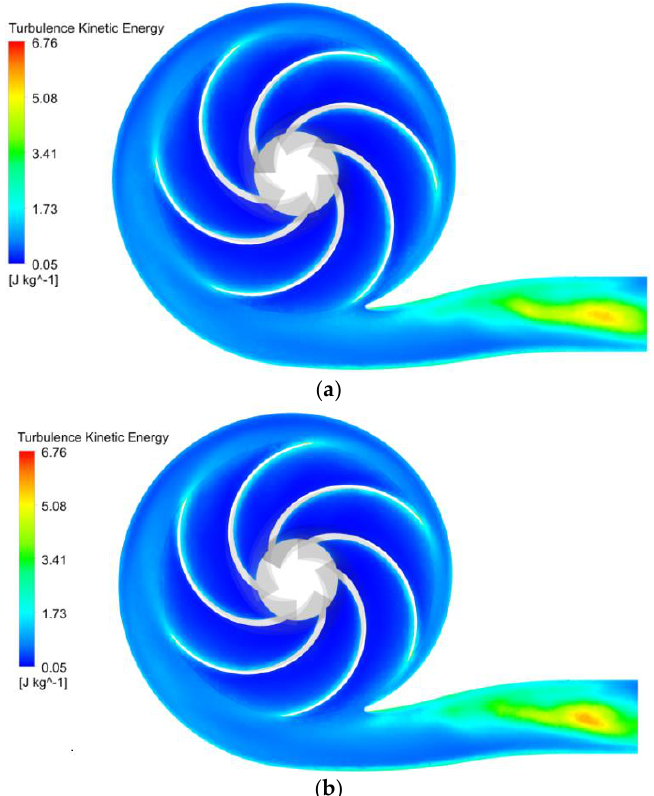
Figure 30. Turbulence kinematic energy contour distribution on the middle section of the discharge chamber under Q 0.6 : ( a ) Impeller phase at 0°; ( b ) Impeller phase at 30°.